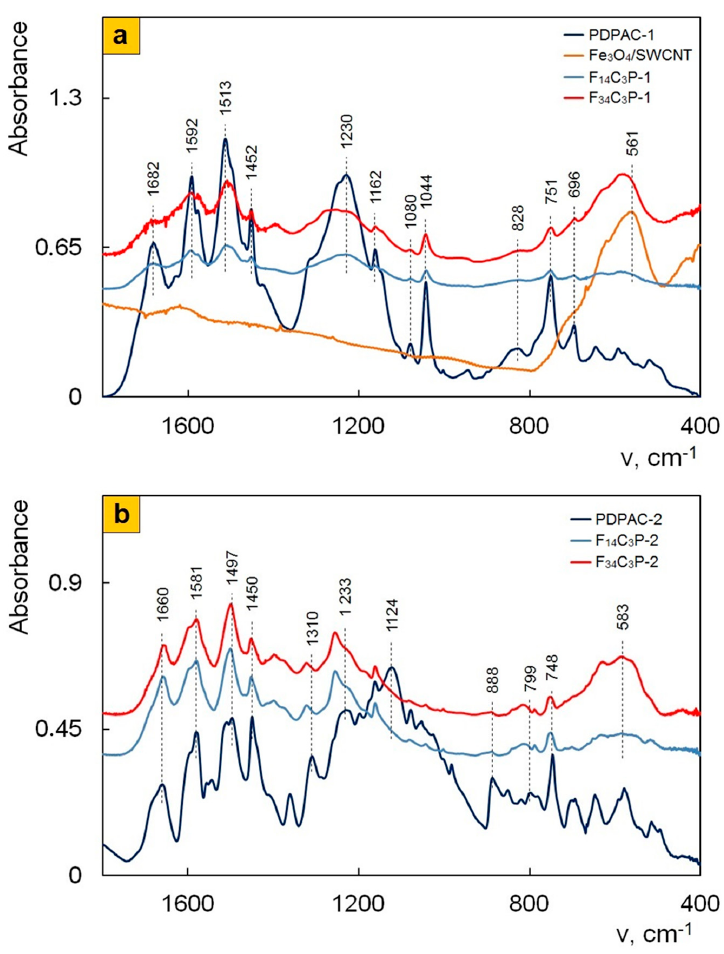
Figure 6. FTIR spectra of PDPAC, Fe 3 O 4 /SWCNT, and Fe 3 O 4 /SWCNT/PDPAC, prepared in alkaline ( a ) and acidic media ( b ).